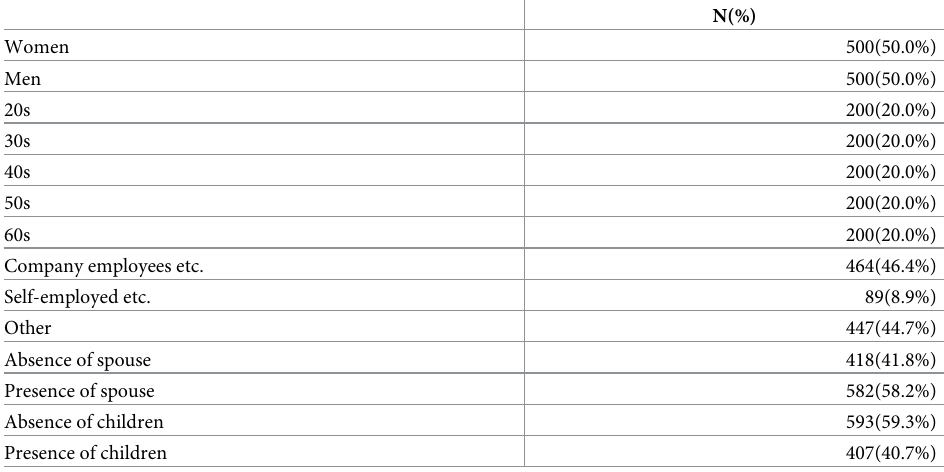
Table 1. Basic information on respondents in